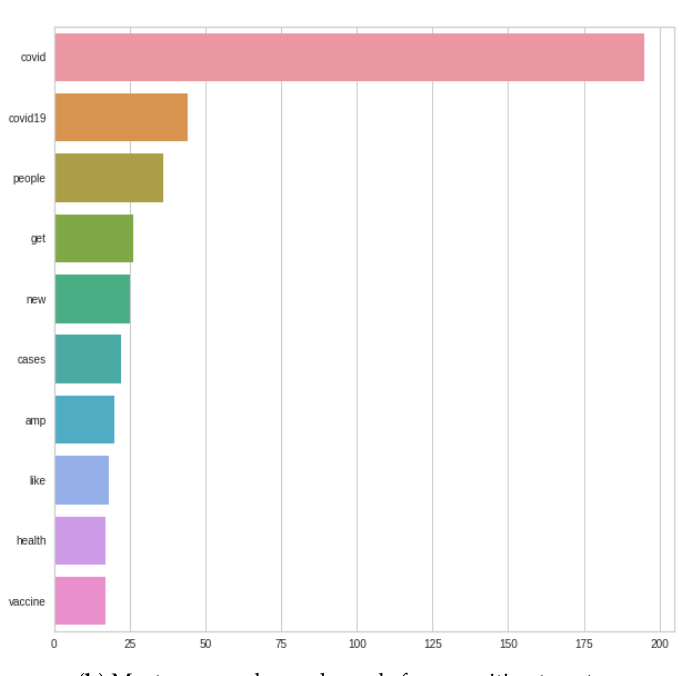
Figure 9. Most commonly used words in negative and positive tweets. The time period stands between 2 September 2021 and 4 September